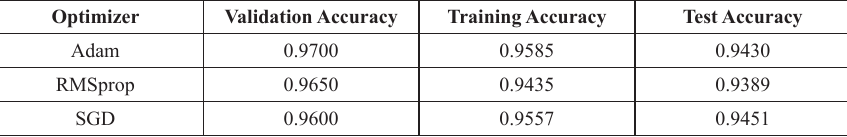
Table 6. Accuracy of different optimizers on validation, train, and test